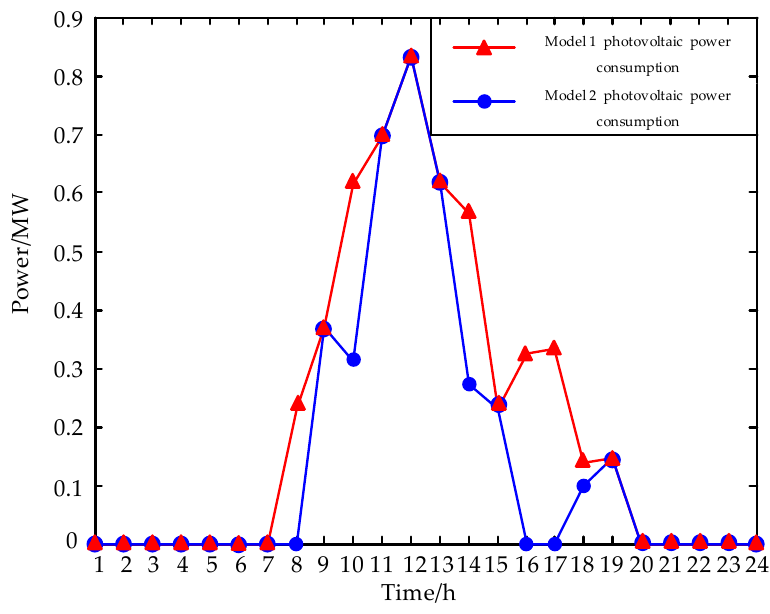
Figure 10. Comparison of photovoltaic accommodation under different models.